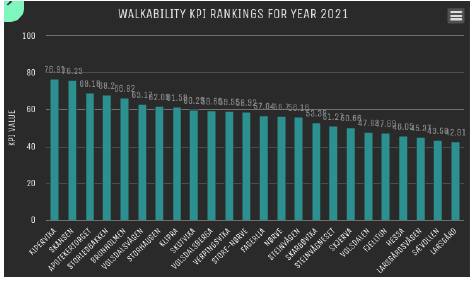
Figure 15. Comparison between all the